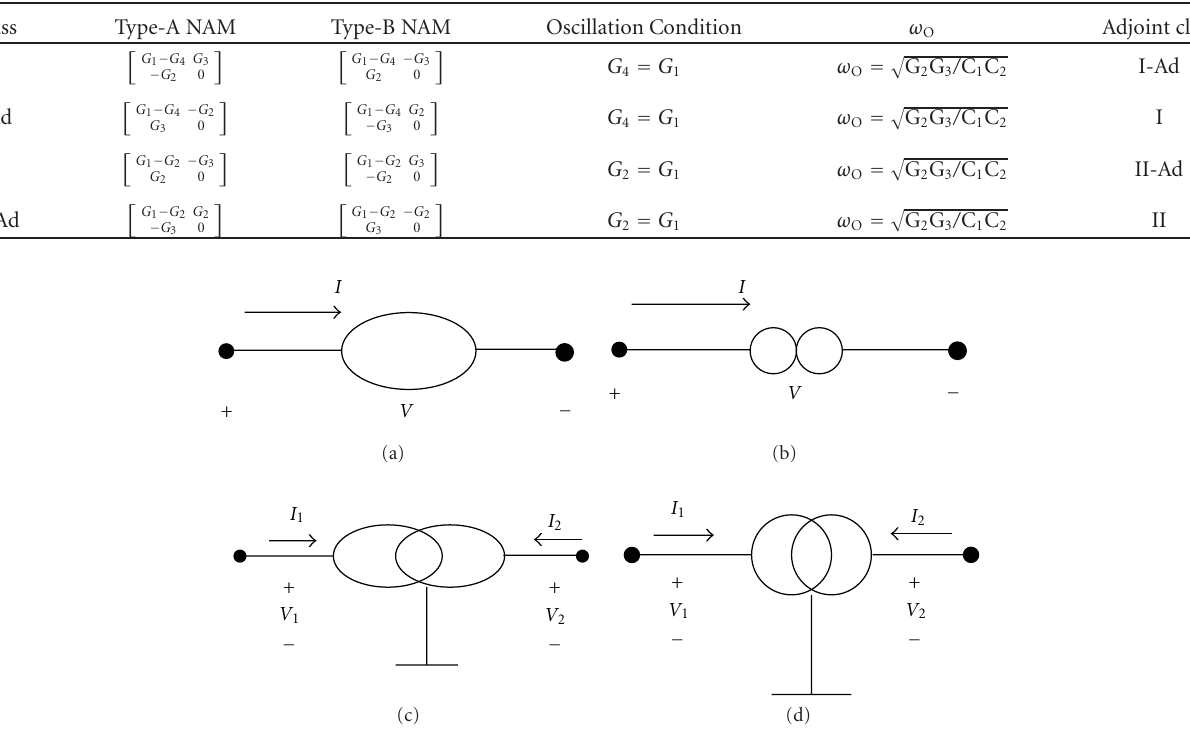
Table 1: A summary of the parameters of the two classes of oscillators.